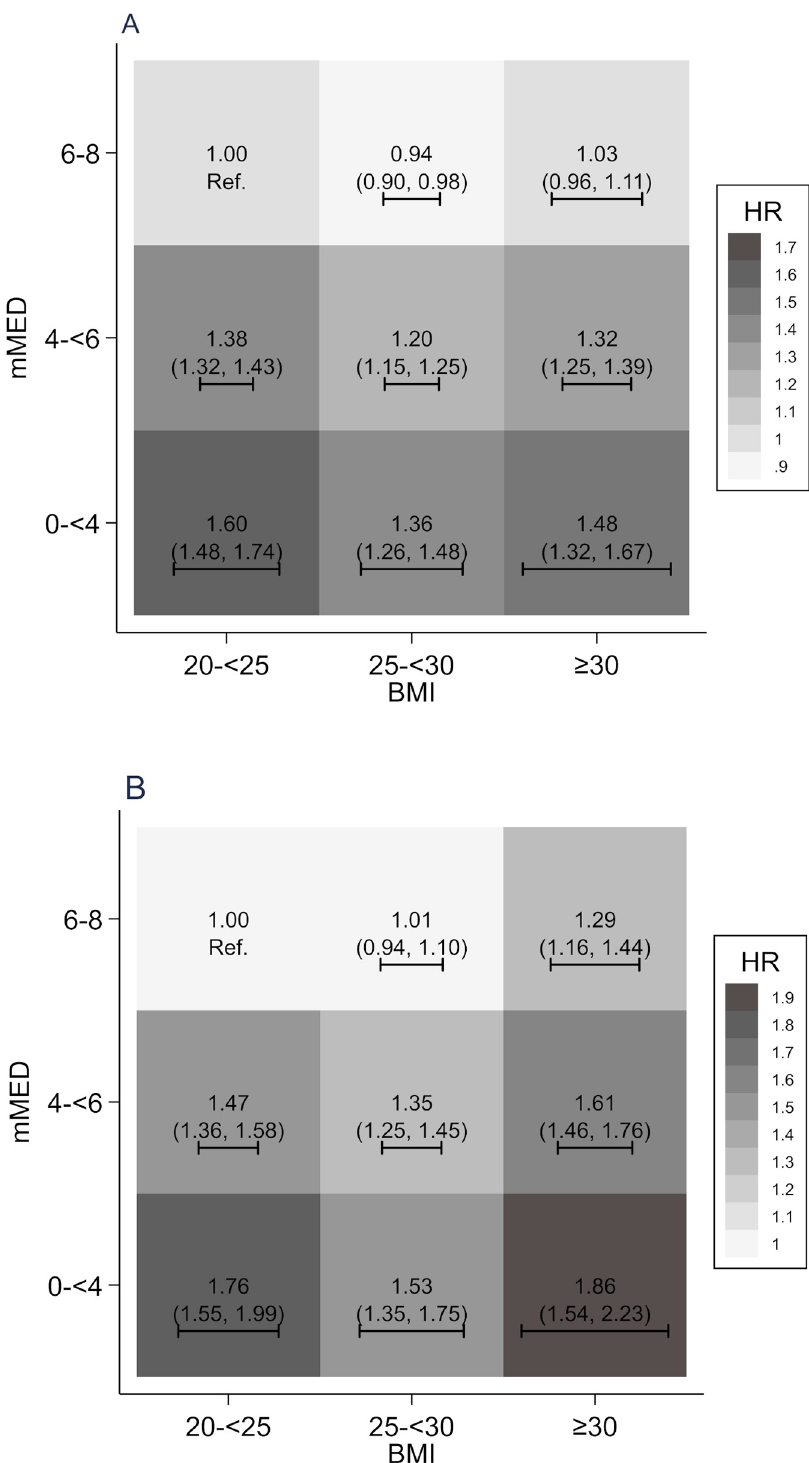
Fig 3. Associations of combinations of BMI and adherence to an mMED with all-cause (A) and CVD mortality (B). Estimated by multivariable-adjusted HRs by use of Cox regression analysis with a normal BMI and high adherence to mMED as the reference. The CI in each subpanel is expressed both in numbers and as a line representing the width. HRs adjusted for sex, age (splines with 2 knots), educational level ( � 9, 10–12, > 12 years, other), living alone (yes or no), leisure time physical exercise during the past year ( < 1 h/w, 1 h/w, 2–3 h/w, 4–5 h/w, > 5 h/w), walking/